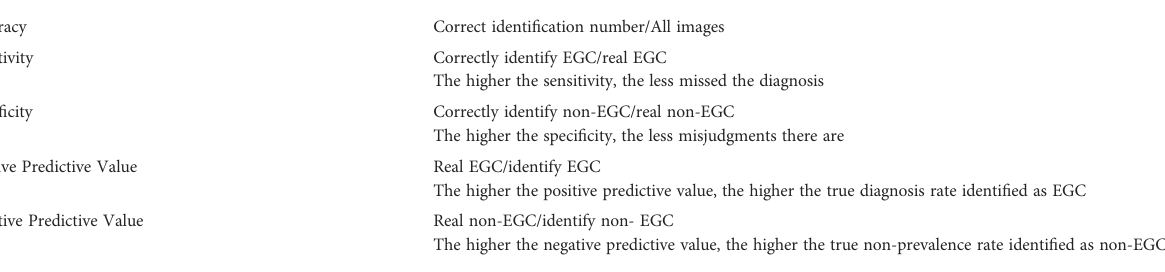
TABLE 1 Evaluation